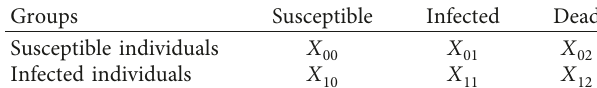
Table 1: Number of individuals at any state for cohort. Groups